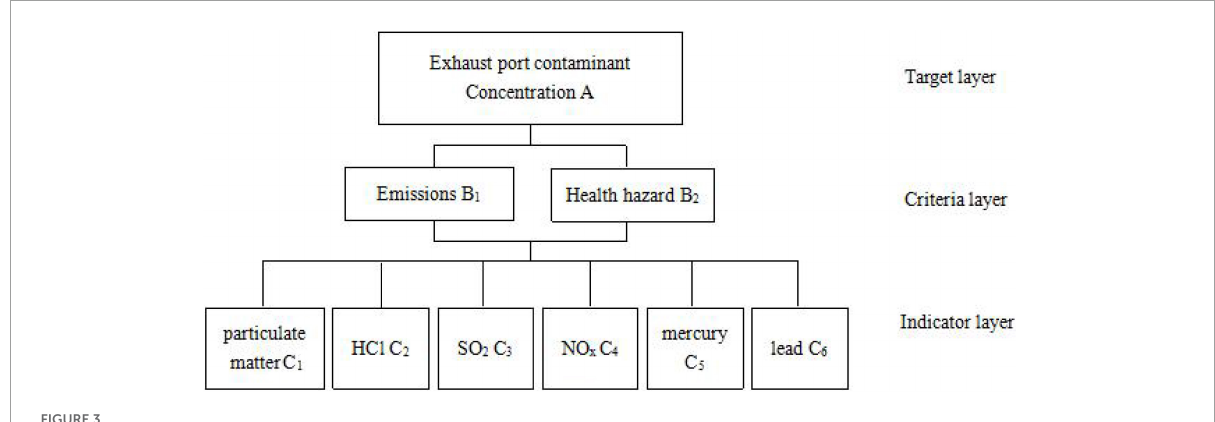
FIGURE3 Hierarchical analysis structure.